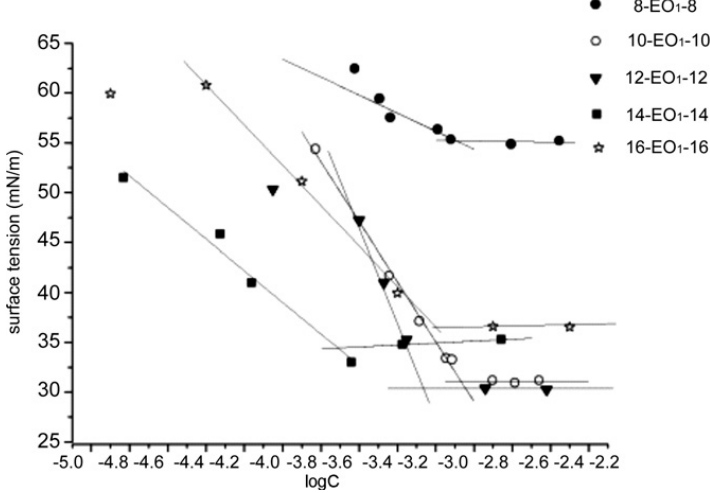
Figure 6. Dependence of cmc on the number of carbon atoms in the hydrocarbon chain (from C 8 to C 16 ) for the surfactant series with one ethylene oxide spacer [161]. Reprinted with permission from ref. [161]. Copright 2021 Elsevier.